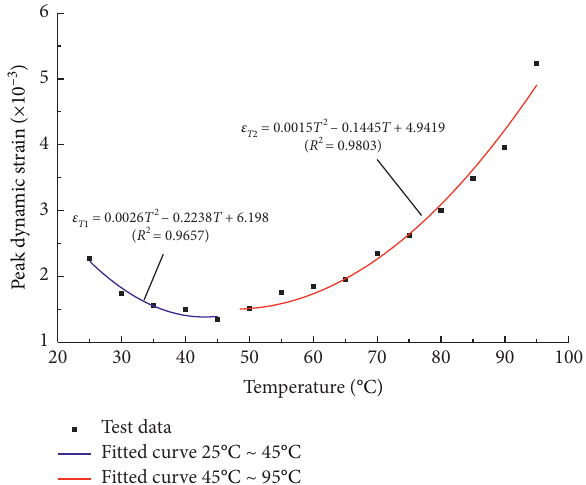
Figure 8: Fitting curve between water bath temperature and dynamic peak strain.